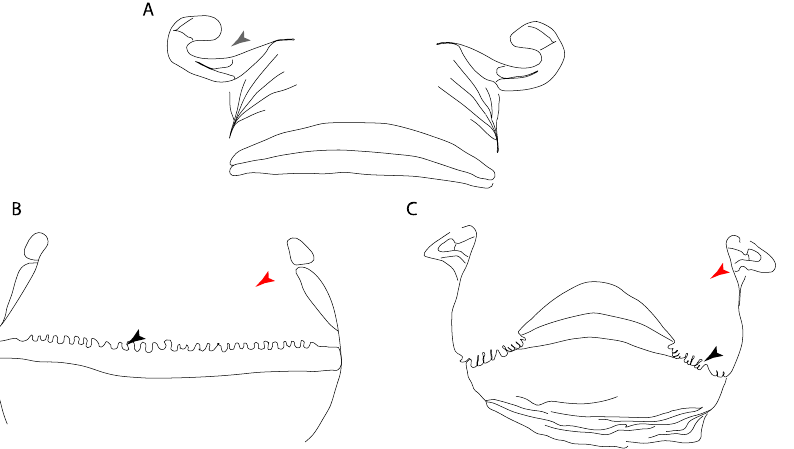
Figure 1. Interpretative drawings of the mouth and nostrils. State (0): ( A ) Zapteryx xyster modified from McEachran et al. Text-Figure 1B in [6]. State (1) ( B ) Rhinoptera jayakari modified from Pradeep et al. Text-Figure 3A in [51] and ( C ) Raja clavata modified from Steven Text-Figure 8 in [52]. Arrowheads: (red) nasal curtain, (back) nasal curtain fringes, (gray) anterior nasal lobe. 32. Anterior nasal lobe: (0) Fails to cover most of the medial half of the naris; (1) covers more than the medial half of the naris.